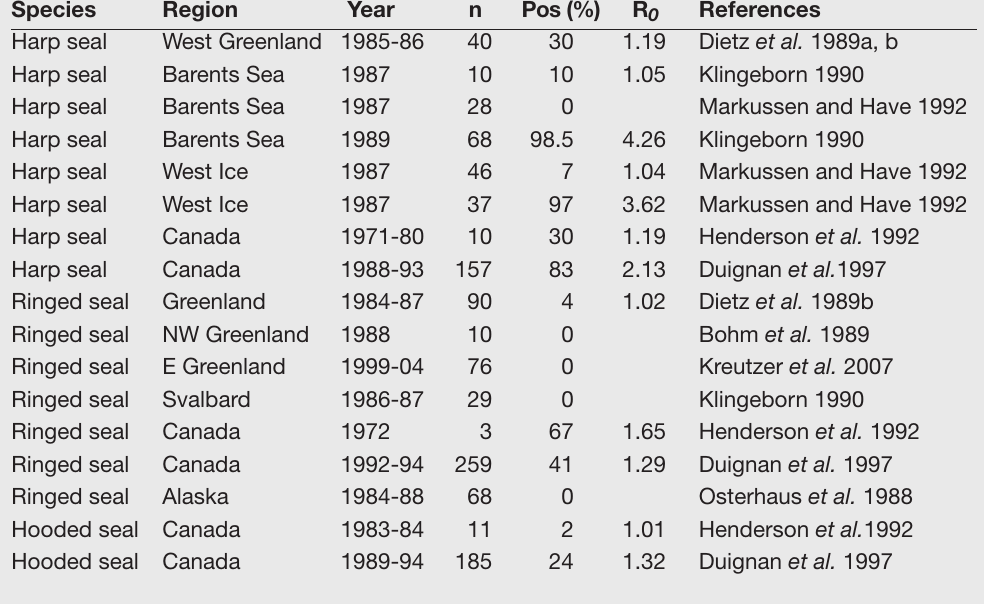
Table 1. Estimates of the basic reproductive number ( R 0 ) of PDV in Arctic seal popula- tions under a scenario where final fractions (f) affected by epizootics are reflected by the proportion seropositive in taken samples. In such a case the basic reproductive number is given by: R 0 = - ln(1 - f)/f (Kermak and McKendrick